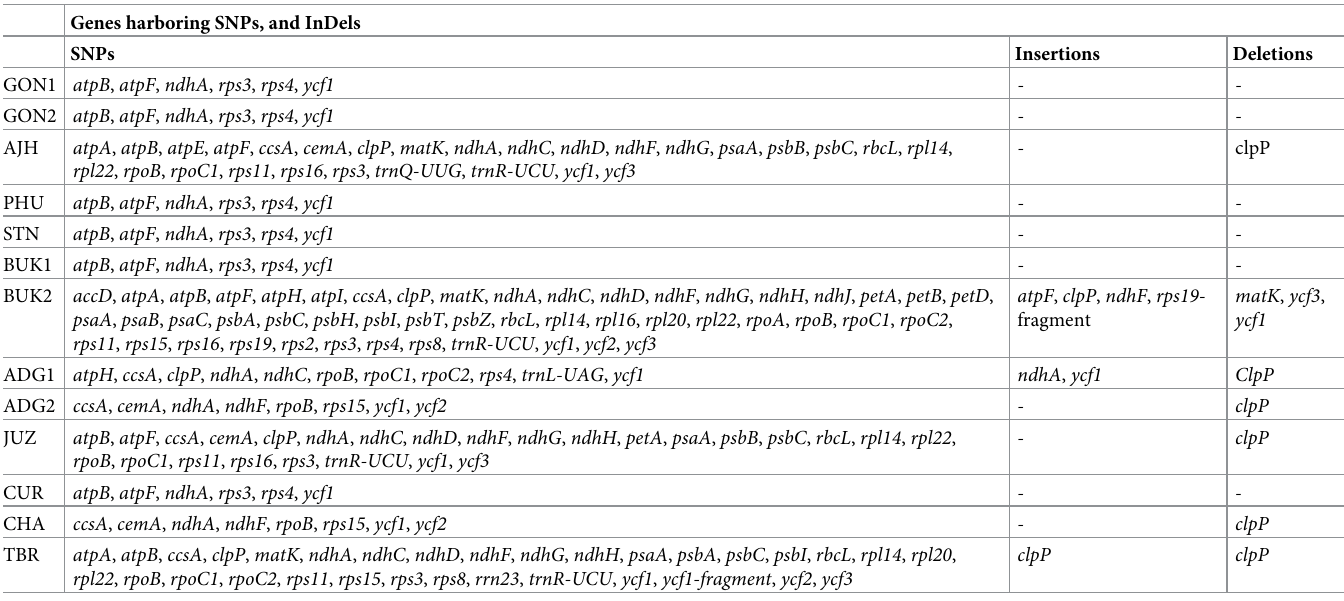
Table 4. Genes harboring SNPs and InDels. Genes harboring SNPs, and